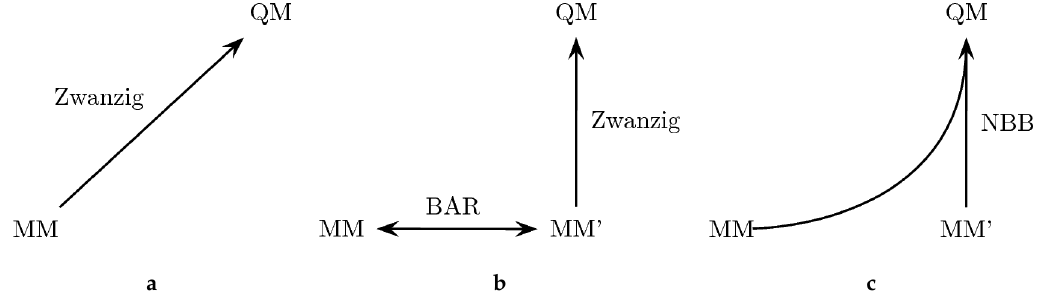
Figure 2. Three ways to calculate the free energy difference between an MM state and a QM state: ( a ) calculating the free energy difference between an MM end state and QM with the Zwanzig equation; ( b ) generating a tailored force field (MM’) with better overlap with the QM target to calculate the free energy difference; ( c ) combining data from both MM, MM’ and